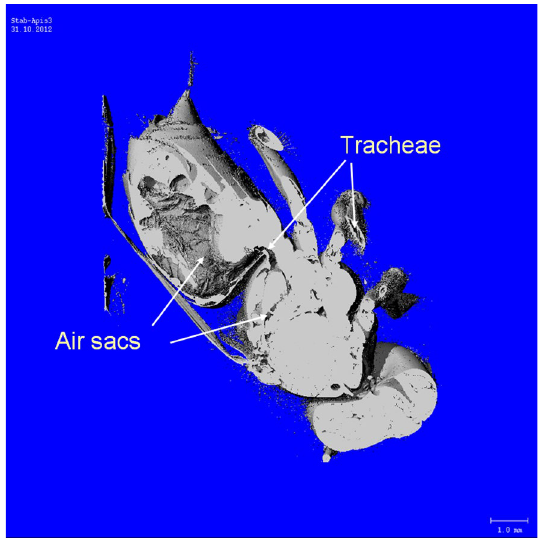
Figure 4. Micro computer tomogram (µCT) of a honeybee, showing abdominal and thoracic air sacs and tracheae of the tracheal system for respiratory heat exchange via internal convection and evaporation (microCT 40, SCANCO Medical, Bruettisellen, Switzerland). Please note that abdominal length is usually up to ~ 60% longer in living animals. See supplementary Video S1 for a slice-wise journey through the whole bee.